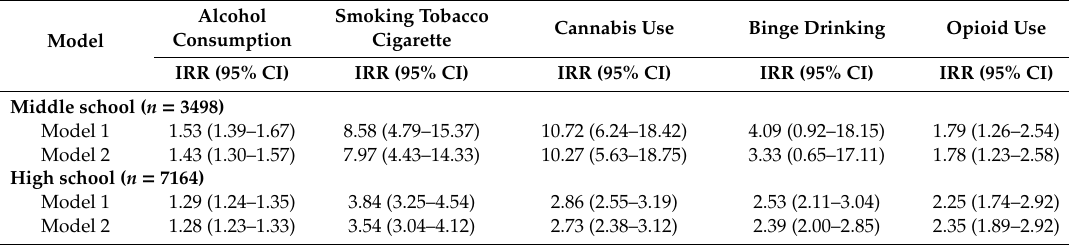
Table 4. Crude and adjusted Poisson regression models for the associations between energy drink consumption in the past 12 months and substance use outcomes stratified by grade level, OSDUHS, 2017 ( n =